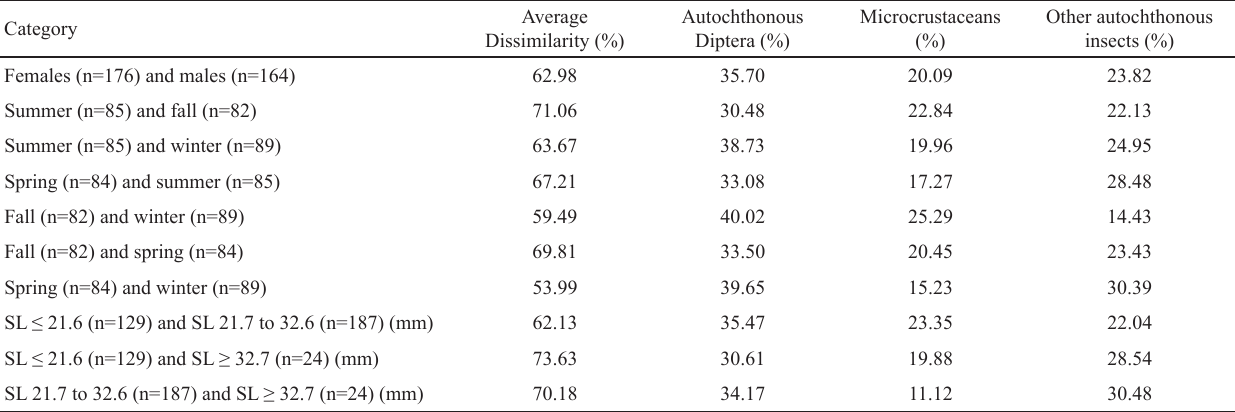
Table 2. SIMPER analysis with paired comparisons of the contribution (by percentage of dissimilarity) in the diet of Atlantirivulus riograndensis of the main food items consumed in relation to sex, seasonality, and ontogeny. Individuals collected at the Banhado dos Pachecos wildlife refuge in the city of Viamão, Rio Grande do Sul, Brazil, in 2012. Standard Length